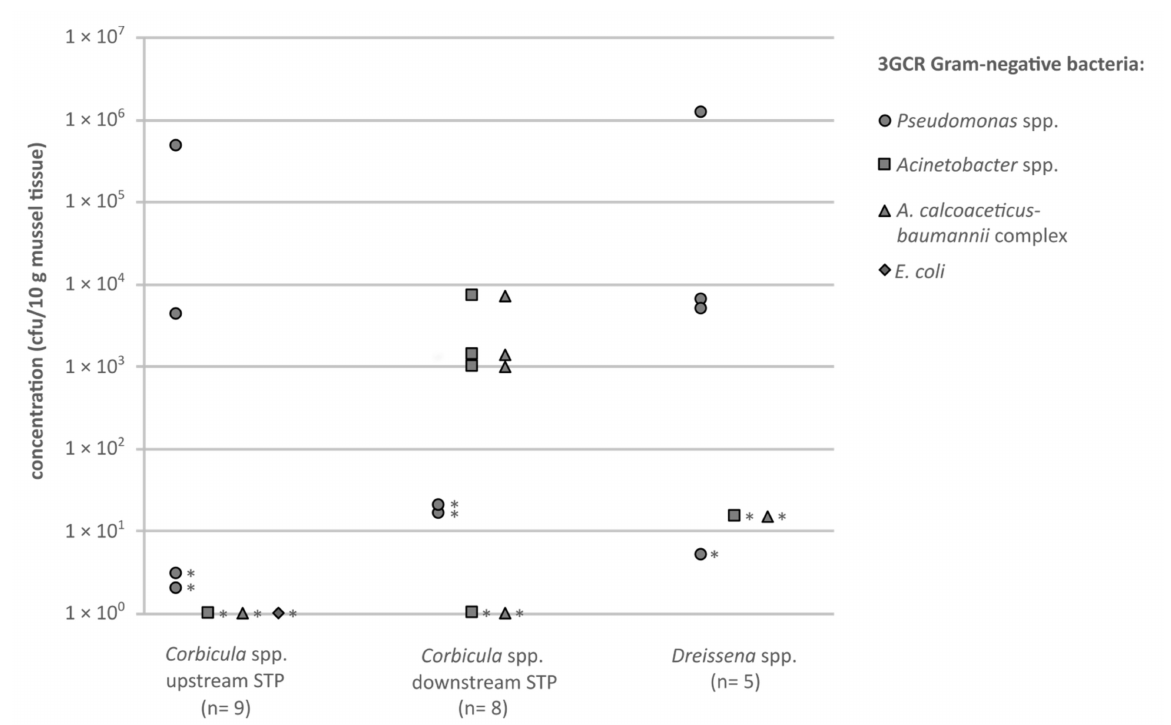
Figure 2. Concentrations (cfu/10 g mussel soft tissue) of antibiotic-resistant (3GCR) Gram-negative bacteria, cultivated on CHROMagar ESBL (circles = Pseudomonas spp.; squares = Acinetobacter spp.; triangles = A. calcoaceticus-baumannii complex; diamonds = E. coli ), originating from the tissue of the investigated mussels. Asterisks mark category values of ≥ x cfu/10 g mussel tissue, the smallest possible value is shown.